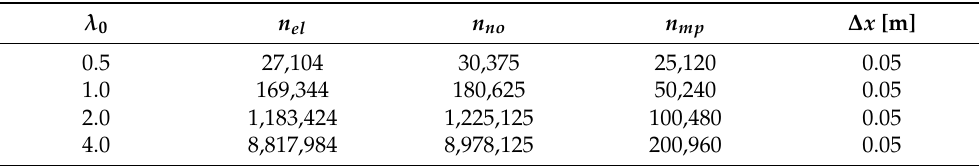
Table 1. The granular column was discretised by 40 elements along the x and y directions, and n pe = 8 were assigned per the initially filled element.